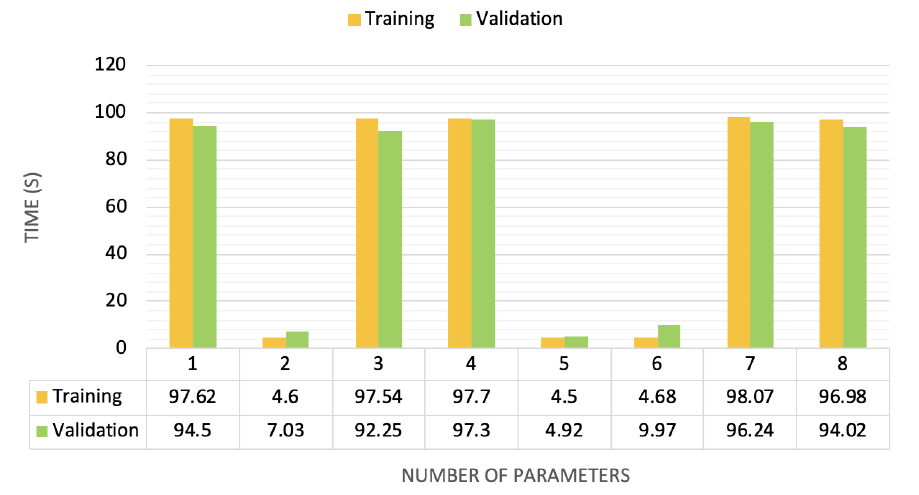
Figure 8. Performance evaluation DRL and blockchain in smart home